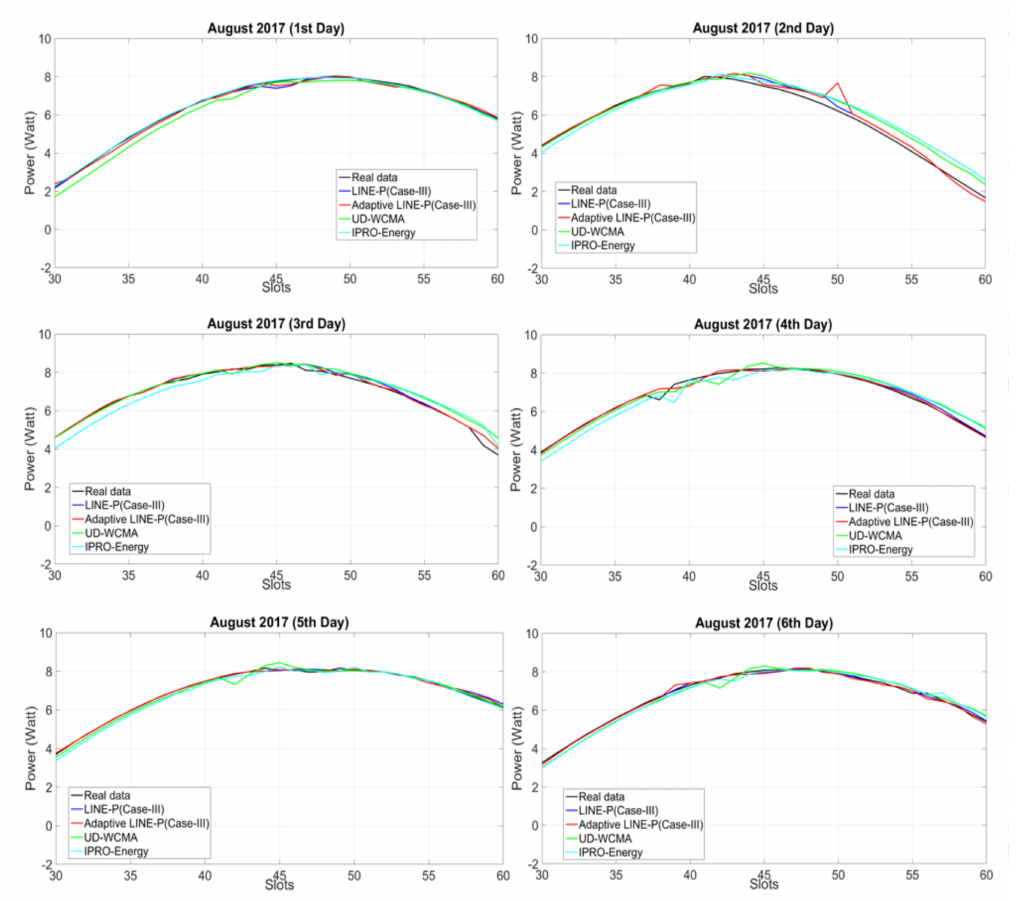
Figure 2. Graphical representation of Adaptive LINE-P (Case III) and state of the art based on the longer (42-min data interval) time period horizon for the solar profile with 30 time slots in 24